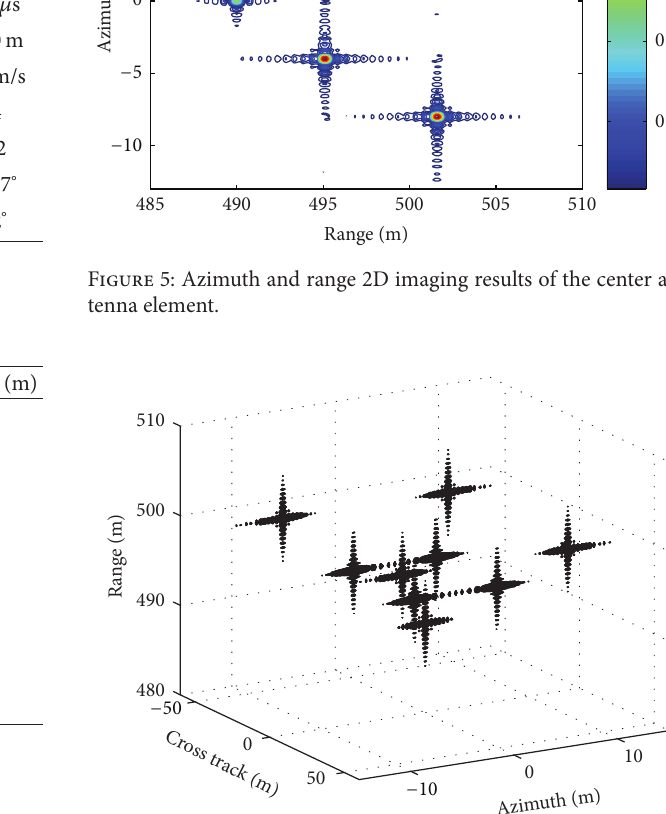
Figure 6: Final 3D image of down-looking sparse array SAR.